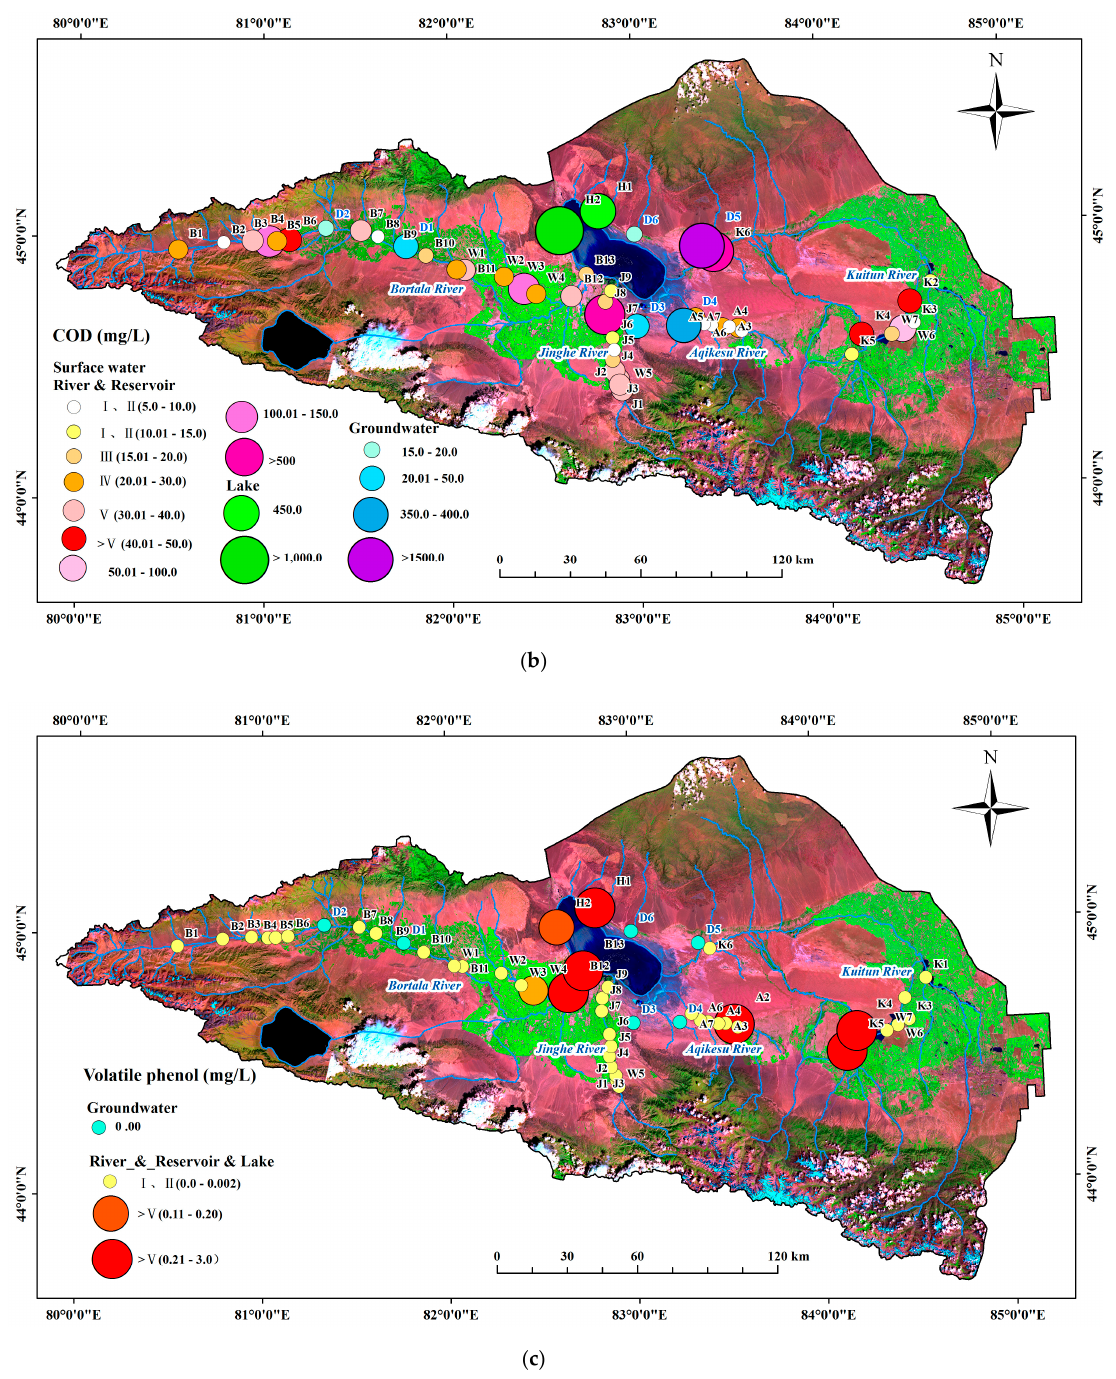
Figure 10. Spatial distribution of organic pollution parameter concentration (NH 3 -N ( a ), chemical oxygen demand (COD) ( b ), and volatile phenol ( c )). oxygen demand (COD) ( b ), and volatile phenol ( c